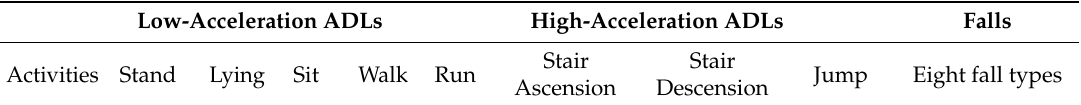
Table 1. The low- and high-acceleration activities of daily life (ADLs) and eight type falls including walking fall, walk and stumble fall, running fall, run and stumble fall, front standing fall, back standing fall, left standing fall, and right standing fall. Low-Acceleration ADLs High-Acceleration ADLs Falls Stair Stair Jump Eight fall types Activities Stand Lying Sit Walk Run Ascension Descension